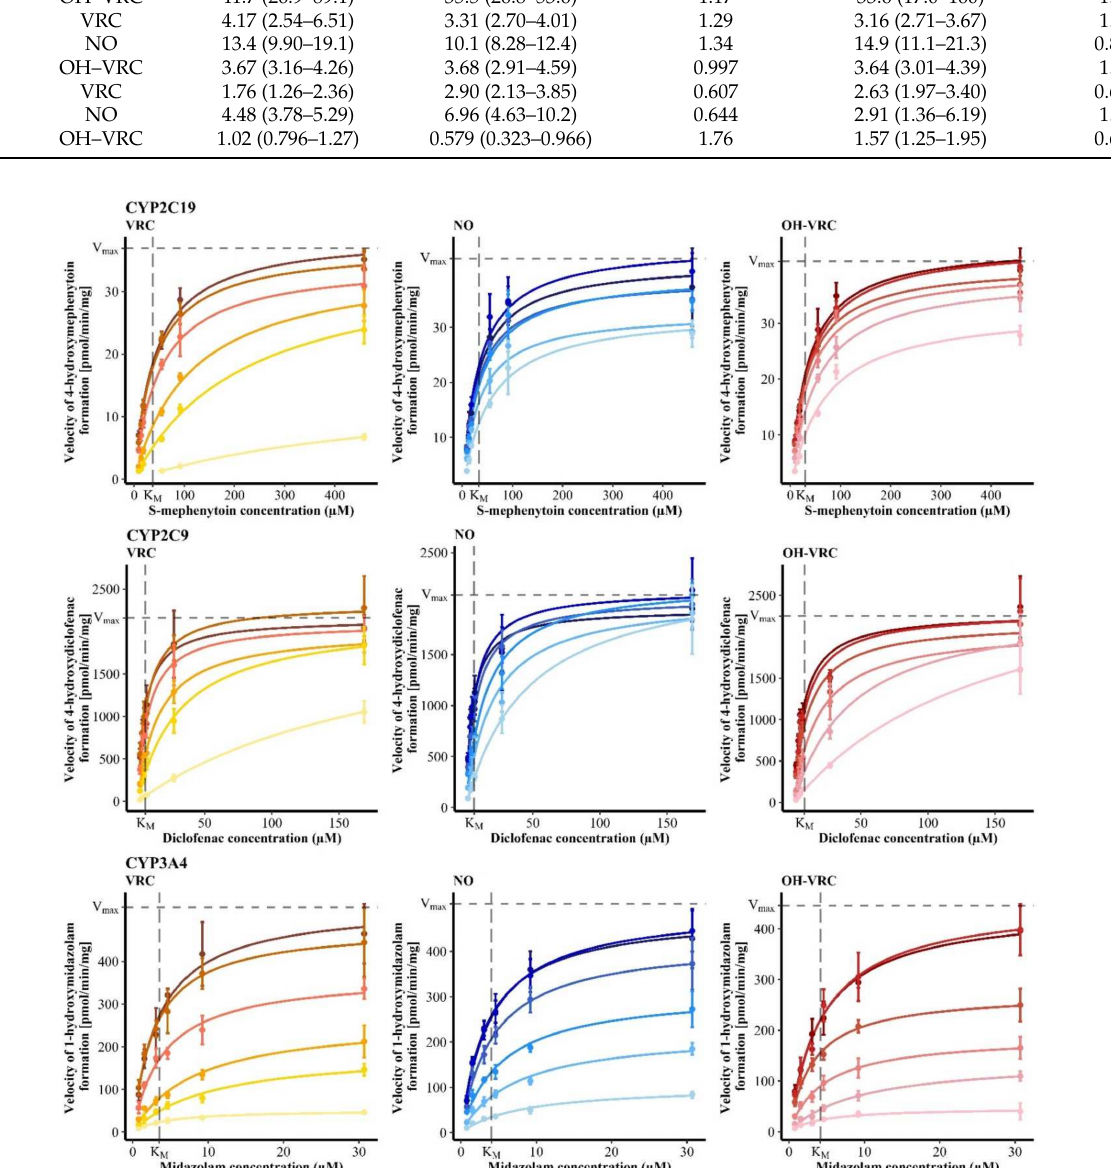
Figure 5. Reaction velocities of 4-hydroxymephenytoin formation by CYP2C19 (top), 4-hydroxydiclofenac formation by CYP2C9 (middle) and 1-hydroxymidazolam formation by CYP3A4 (bottom) in function of the substrate concentration under the influence of increasing concentrations of the inhibitors (increasing inhibitor concentration with decreasing color intensity) voriconazole (VRC, 0, 0.1, 1, 5, 10, 100 µ M), voriconazole N -oxide (NO, 0, 0.0958, 0.958, 3.83, 9.58 and 34.2 µ M) and hydroxyvoriconazole (OH–VRC, 0, 0.0958, 0.958, 3.83, 9.58 and 34.2 µ M) in human liver microsomes. Data points—mean reaction velocity ( n = 2–4); error bars—standard deviation of reaction velocity; solid lines—estimated enzyme kinetics; dashed lines—Michaelis-Menten constant (K M ) and maximum reaction velocity (V max ) of the respective uninhibited